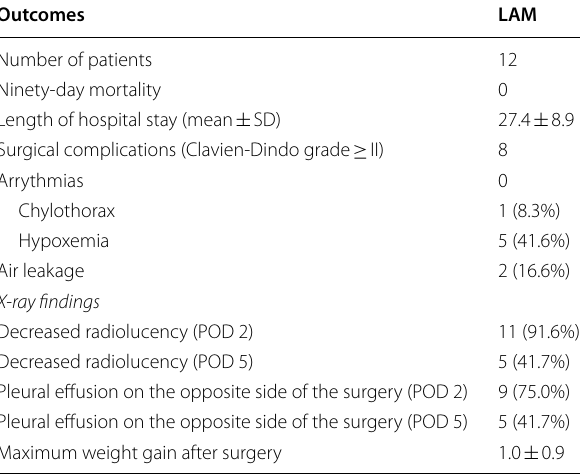
Table 3 Surgical outcomes after thoracic surgery